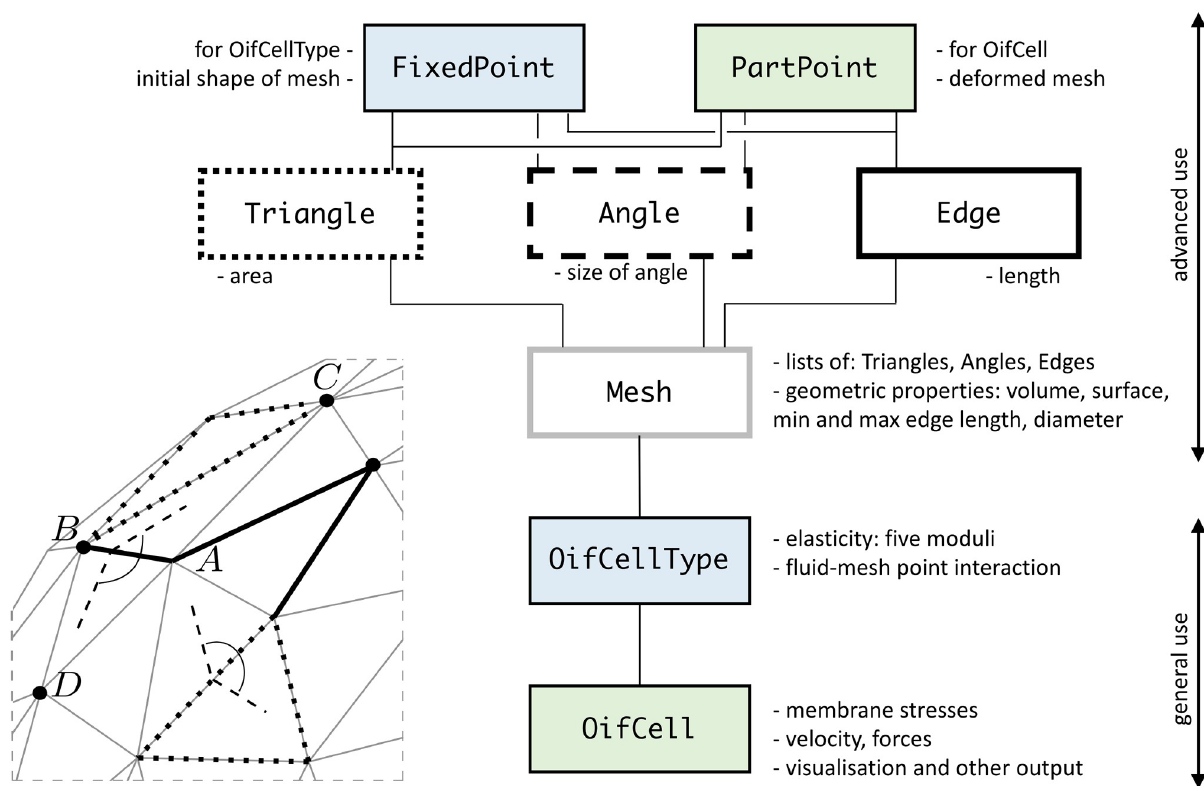
Fig 1. Left bottom: Part of the triangular mesh. Geometric entities used to define the elasticity are highlighted: four points (bold dots), three edges (full bold lines), two triangles (dotted lines) and two angles between neighbouring triangles (dashed lines and an arc). Right: Scheme of basic PyOIF classes. Linking of classes and geometrical entities (depicted in the left part of the figure) is emphasized by bold dots (mesh points), full bold lines (edges), dotted lines (triangles), dashed lines (angles) and bold grey lines (mesh).